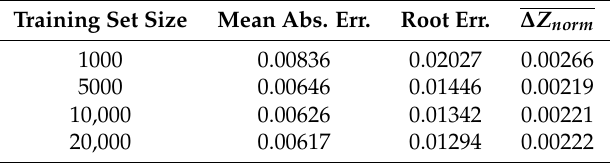
Table 6. Statistics for various training set sizes. The KBestMod feature set was used with the random forest